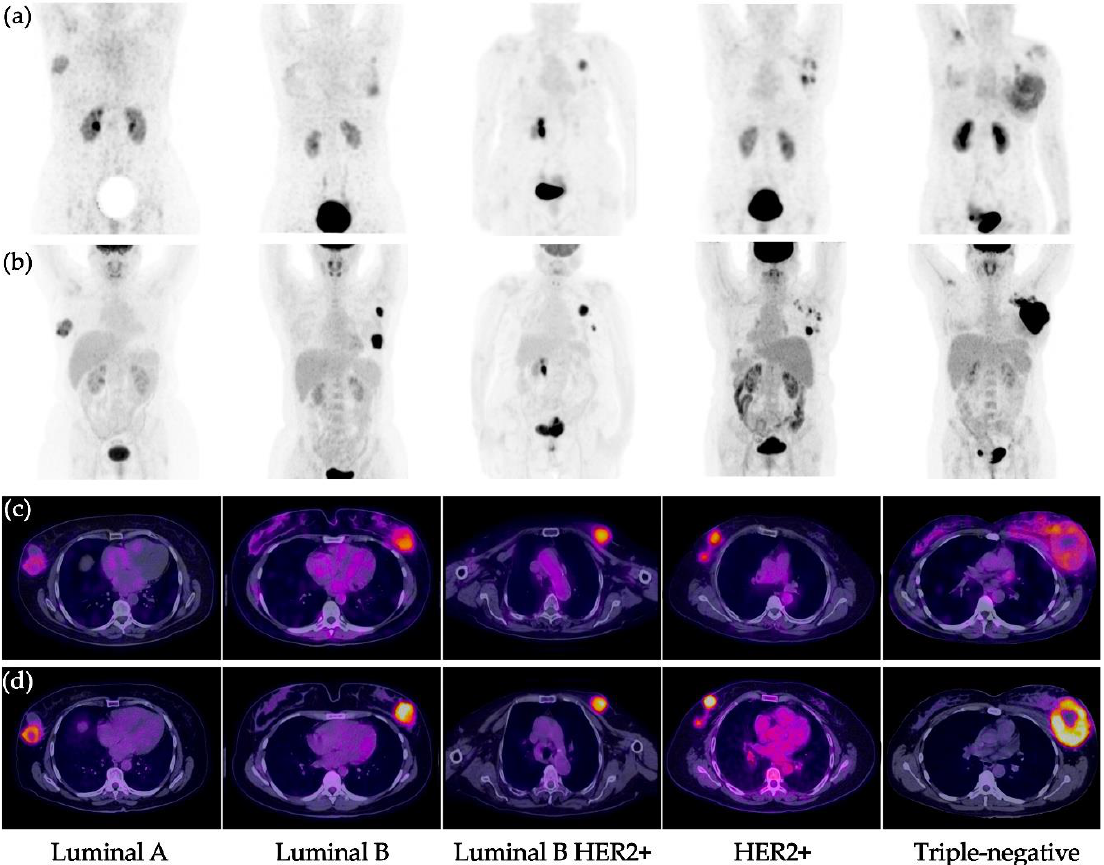
Figure 3. Primary breast cancer tumors. ( a ) [ 99m Tc]Tc-iFAP MIP, ( b ) [ 18 F]FDG MIP, ( c ) [ 99m Tc]Tc-iFAP SPECT/CT, and ( d ) [ 18 F]FDG PET/CT. All primary lesions show concordant uptake between both molecular imaging methods. [ 99m Tc]Tc-iFAP uptake is decreased in pure hormonal molecular subtypes (Luminal A and B) and elevated in subtypes with HER2+ expression (Luminal B HER2+ and pure HER2+). The triple negative subtype shows moderate and heterogeneous uptake. MIP: maximum intensity projection.